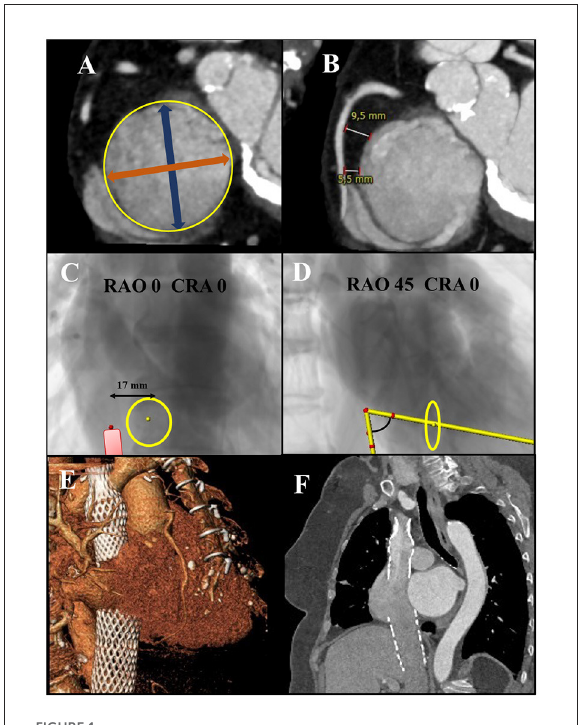
FIGURE1 (A) CCT reconstruction for the assessment of tricuspid annular sizing before TTV annuloplasty repair or TTV replacement. Yellow circle represents tricuspid annular perimeter, blue double-headed arrow the anteroposterior diameter, and orange double-headed arrow the septo-lateral diameter. (B) CCT reconstruction assessing the distance between the tricuspid annulus and the right coronary artery. (C) Antero-posterior fluoroscopic view of the CCT-derived IVC-RA junction to mid-tricuspid annular distance. (D) Fluoroscopic right anterior oblique view demonstrating the angulation to be undertaken by the device delivery system. (E) CCT 3-dimensional reconstruction after Tric-valve implantation. (F) CCT coronal view after Tric-valve